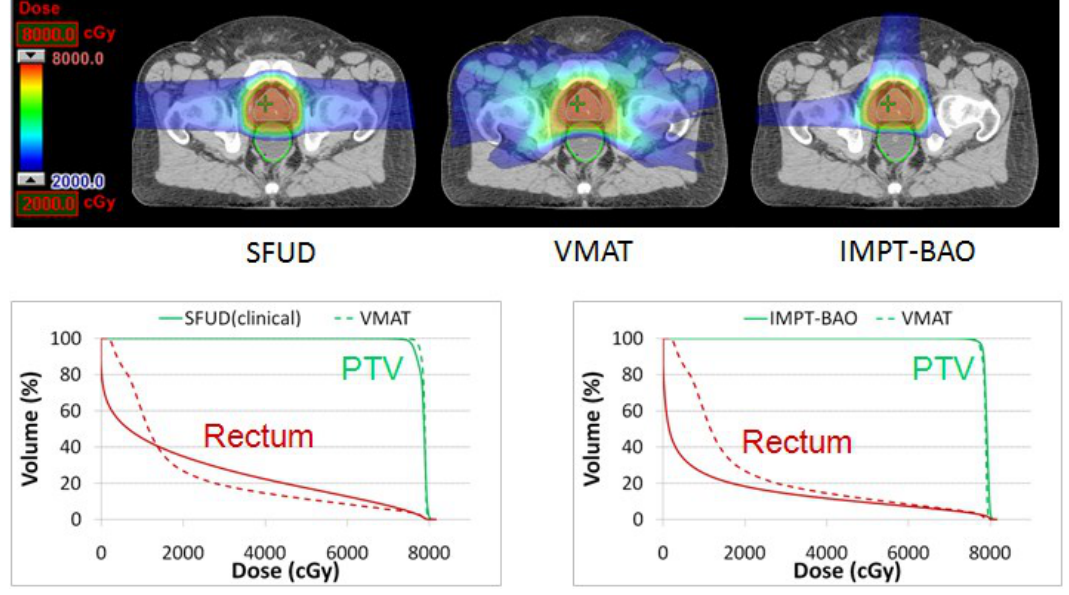
Figure 2. Comparison of SFUD, VMAT and IMPT treatment plans for one prostate cancer patient. Here SFUD represents a two-beam IMPT single field uniform dose distribution plan. This plan is used to treat patients at our institution. VMAT represents a photon volumetric modulated arch therapy plan. IMPT-BAO represents a class three-angle IMPT plan, where BAO interprets beam angle